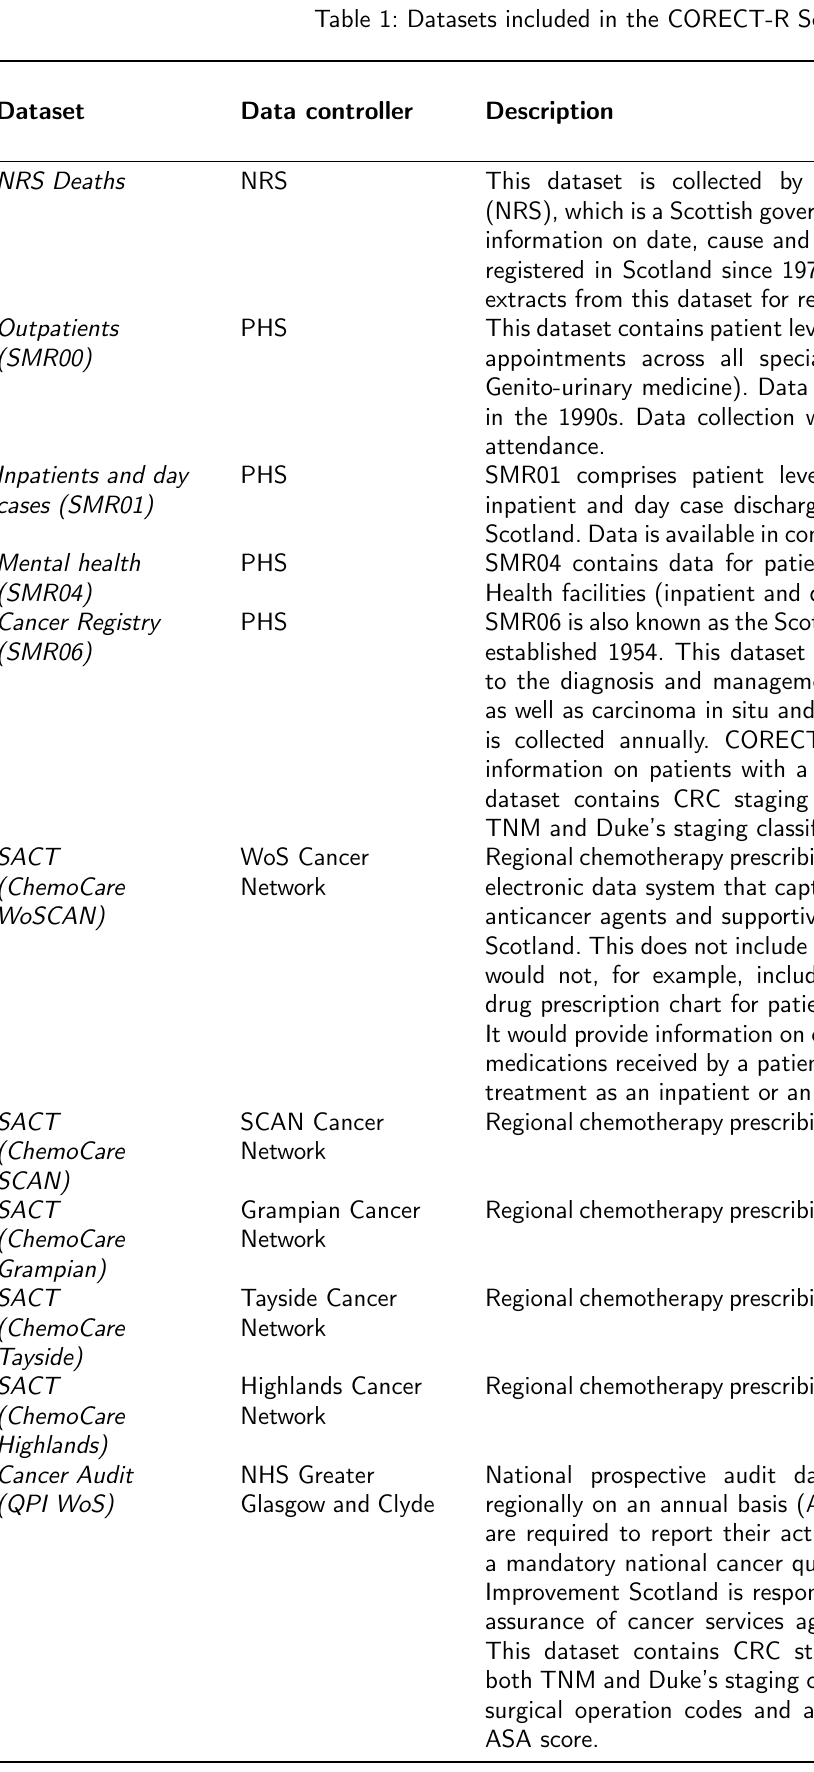
Table 1: Datasets included in the CORECT-R Scotland